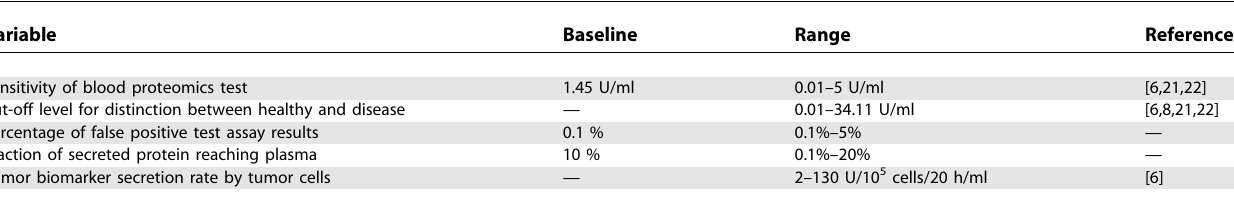
Table 2. Variables Used to Test the Tumor Biomarker Assay Model CA125